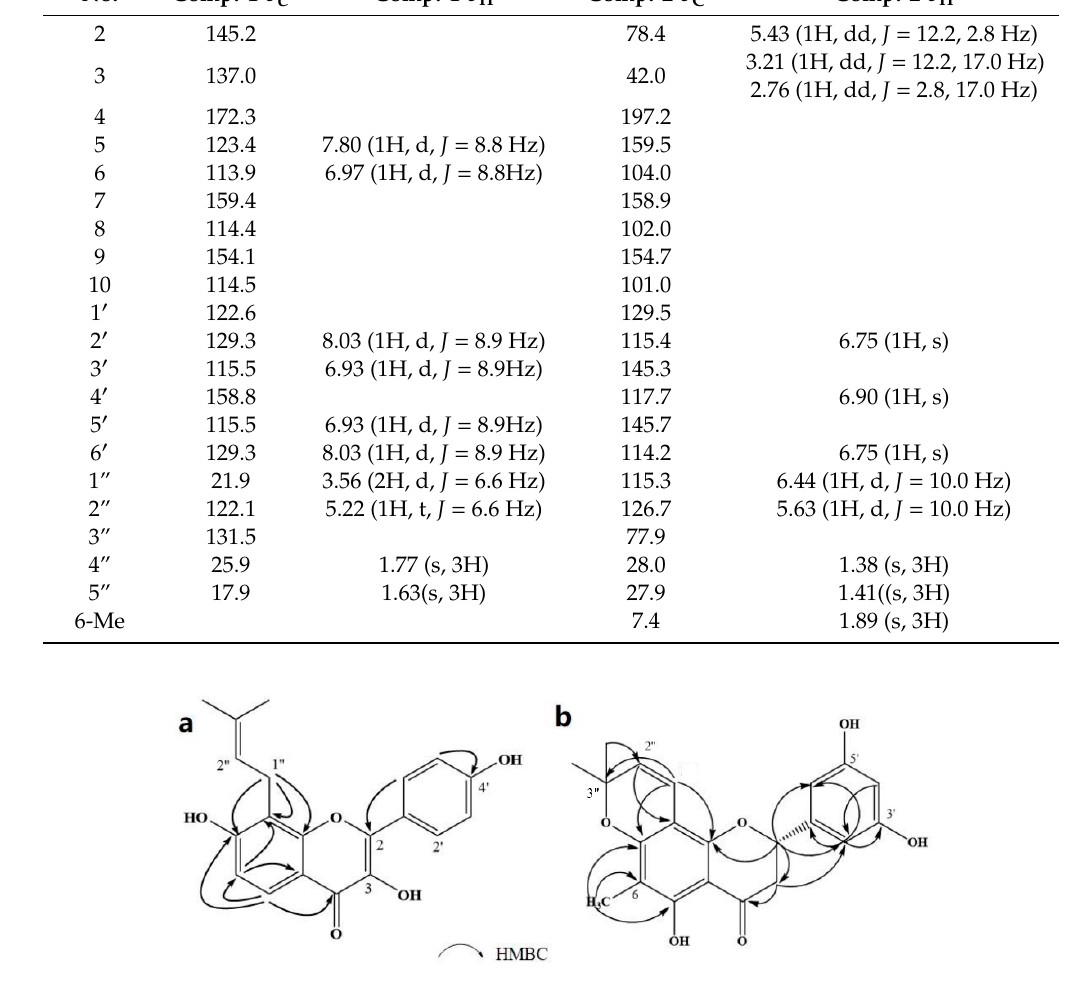
Figure 1. Structures of compounds: ( a ) Compound 1 and ( b ) Compound 2 . Table 1. Data for Compounds 1 and 2 in DMSO- d 6 (600 MHz for 1 H-NMR, 150 MHz for 13 C-NMR). No.